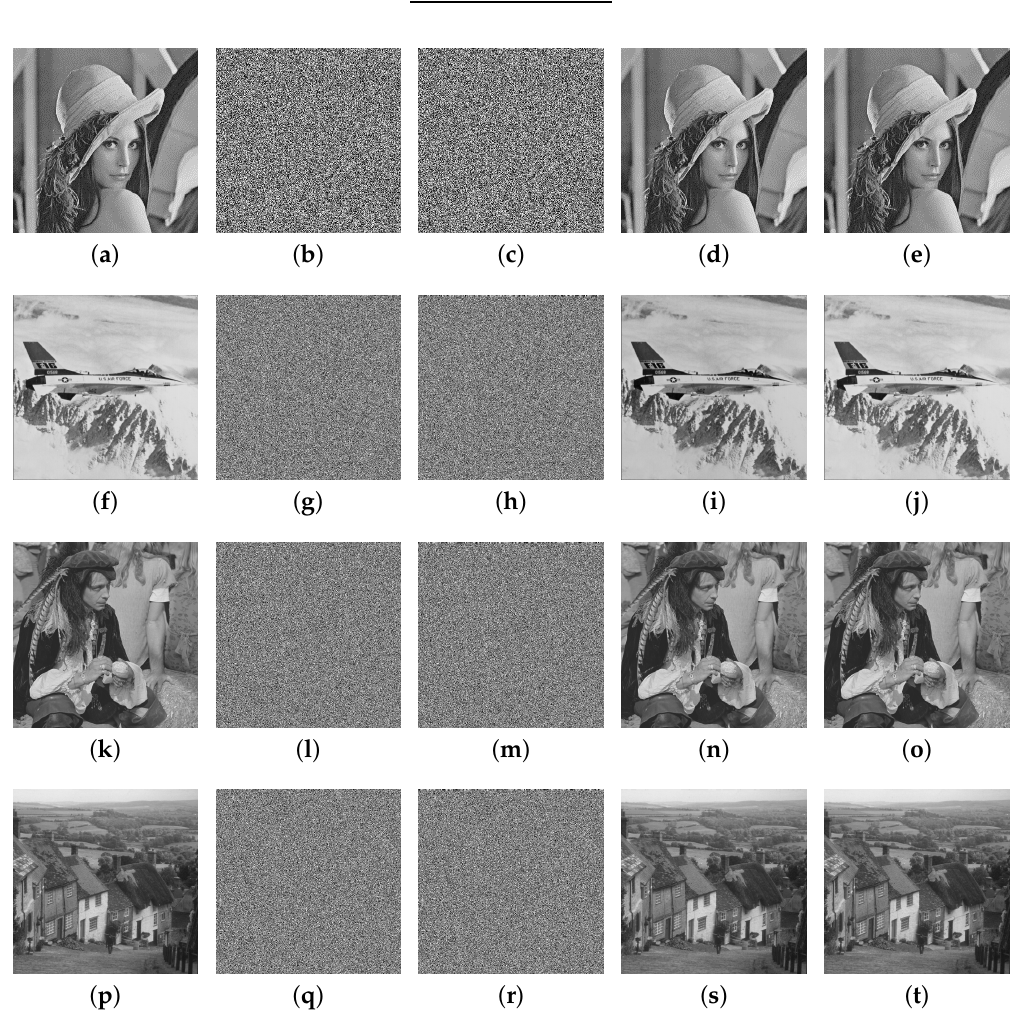
Figure 6. Different stages of images Lena, F-16, Man and Hill with 4095 bits of hidden data under n = 3 and PSNR values of the Directly decrypted image are 54.719 dB, 44.913 dB, 47.637 dB and 54.526 dB, respectively: ( a ) Lena’s original image; ( b ) Lena’s encrypted image; ( c ) Lena’s encrypted image with hidden data; ( d ) Lena’s directly decrypted image; ( e ) Lena’s restored image without loss; ( f )